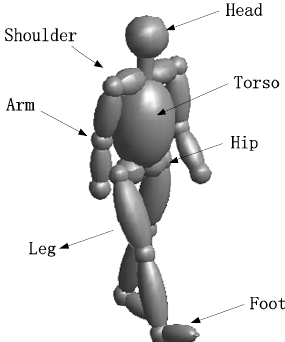
Figure 1. Boulic model of a human.